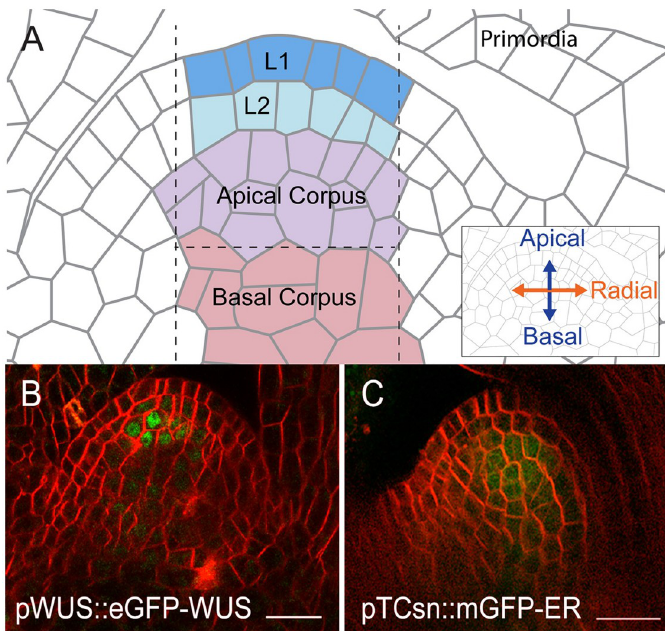
Fig 2. Organizational structure of the SAM. (A) Diagram showing a median longitudinal section of the SAM and depicting three distinct clonal layers. The tunica encompasses the L1 and L2 cell layers. The corpus is subdivided into the Apical corpus and Basal corpus. Vertical dashed lines represent the outer edges of the region used in experimental analysis. The horizontal dashed line represents the separation between the Apical corpus and Basal corpus. The L1 (blue), L2 (light blue), Apical corpus (purple), and Basal corpus (red) cells that fall within the region used for experimental analysis. These limits were manually determined for each experimental SAM image. (B) Median longitudinal section of the SAM showing the WUS protein domain (pWUS::eGFP-WUS) in a 9 day old SAM. (C) Median longitudinal section of the SAM showing the cytokinin signaling reporter (pTCSn::mGFP5-ER) in a 9 day old SAM. eGFP-WUS and mGFP5-ER (green) are overlaid on FM4–64 plasma membrane stain (Red). Scale bars = 20 μ m.